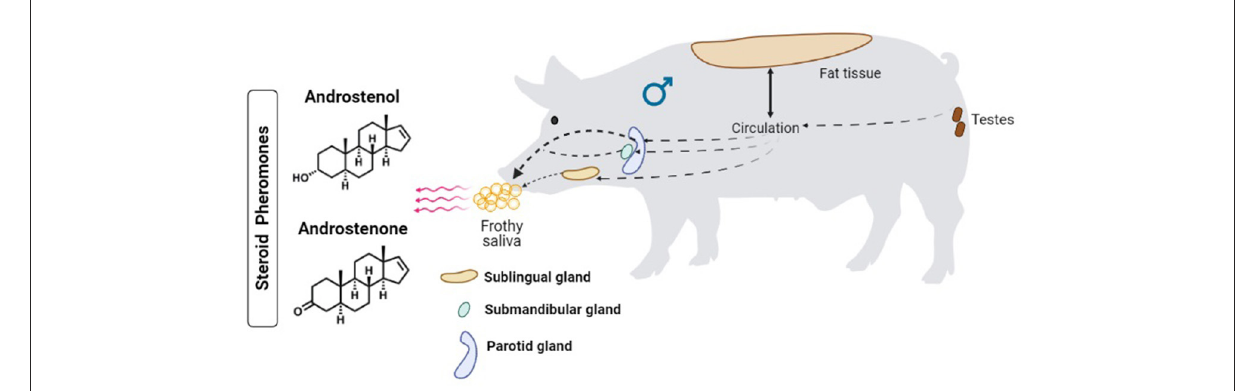
FIGURE1 Mechanism of secretion and excretion of steroid pheromones from